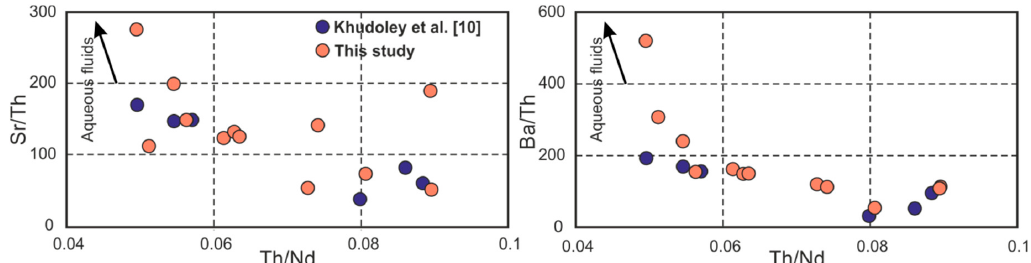
Figure 17. Sr/Th vs. Th/Nd and Ba/Th vs. Th/Nd diagrams for the Suordakh event mafic intrusions, Figure 17. Sr / Th vs. Th / Nd and Ba / Th vs. Th / Nd diagrams for the Suordakh event mafic intrusions, showing the possible influence of aqueous fluids on the magma composition [79]. showing the possible influence of aqueous fluids on the magma composition